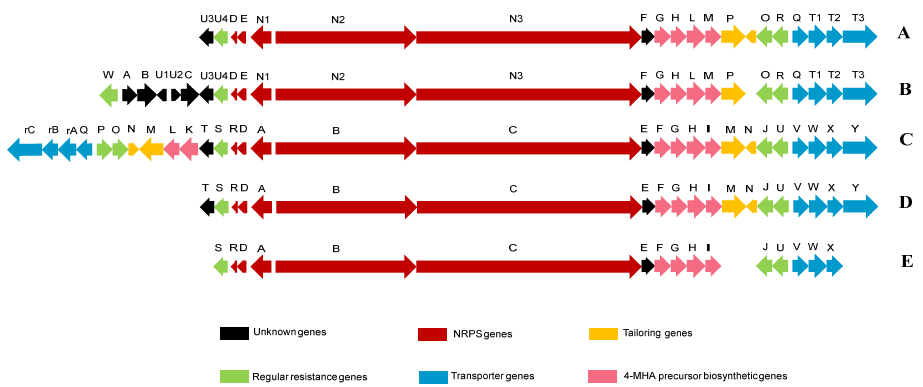
Figure 5. Genetic organization of actinomycin D biosynthesis gene clusters (BCGs) of S. griseus SCSIO PteL053 ( A ), Streptomyces costaricanus SCSIO ZS0073 ( B ), Streptomyces chrysomallus ATCC11523 ( C ), Streptomyces antibioticus IMRU 3720 ( D ), and Streptomyces parvulus ( E ).